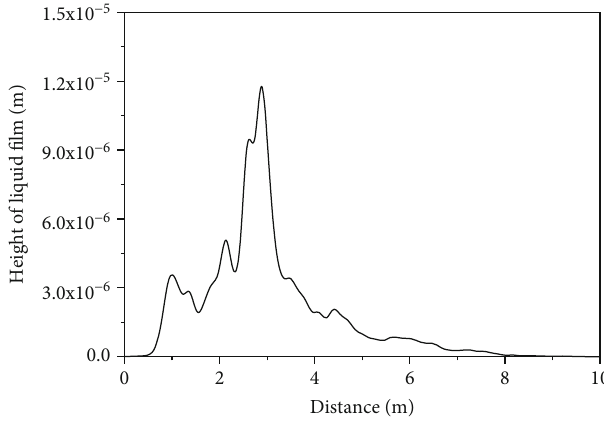
Figure 12: The droplet distribution of a single-rotor model when free stream velocity is 3m/s.